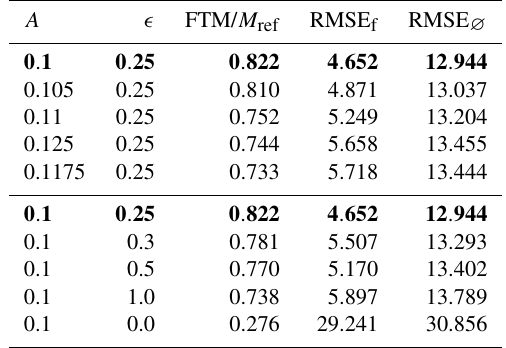
Table 3. Parameters and metrics for simulations with different val- ues of A and (cid:15) for the reference simulation. FTM is the final total mass, and RMSE f and RMSE ∅ are the concentration field RMSE at the end of simulations with and without